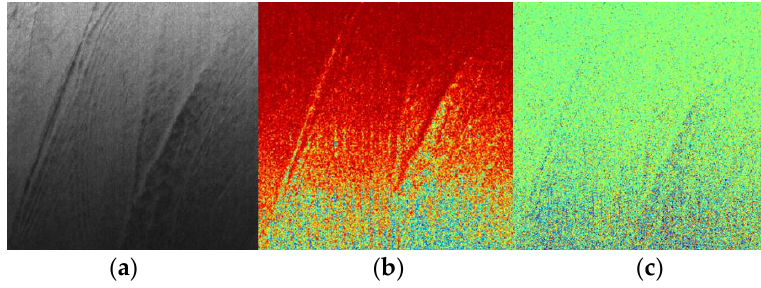
Figure 10. ( a ) Intensity ( b ) coherence and ( c ) phase image of the internal wave area.